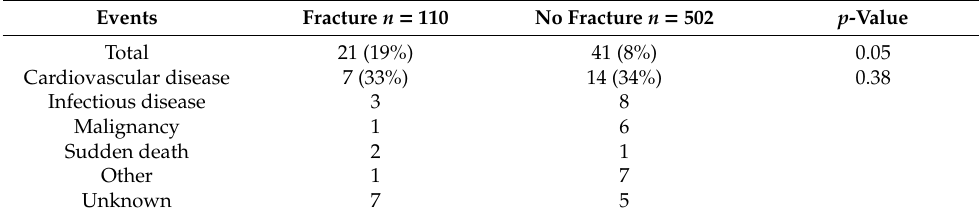
Table 4. Death events and causes in patients with or without vertebral fracture. Table 5. Multivariate Cox-proportional hazard model for risk factors of mortality in CKD patients not on dialysis.